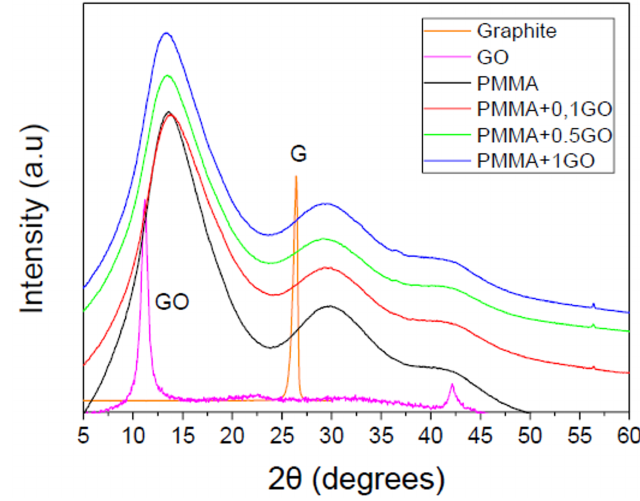
Figure 1. X-ray diffraction patterns of graphite, GO, neat PMMA, and PMMA/GO